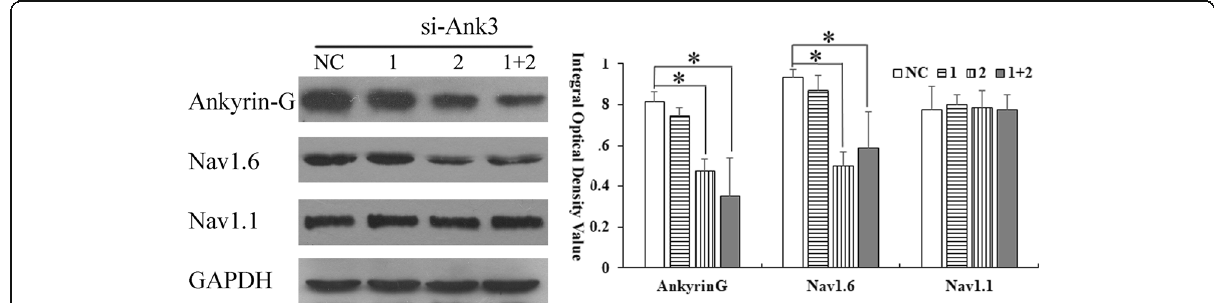
Fig. 2 Protein levels of Ankyrin-G, Nav1.6 and Nav1.1 after siRNA interference in HT22 cells. Ankyrin-G, Nav1.6, Nav1.1 and GAPDH were detected as the immunopositive bands with molecular weight around 190 kDa, 260 kDa, 260 kDa and 146 kDa respectively. We found similar changes of ankyrin-G and Nav1.6 IDV protein level after siRNA silence in group2 and group1 +